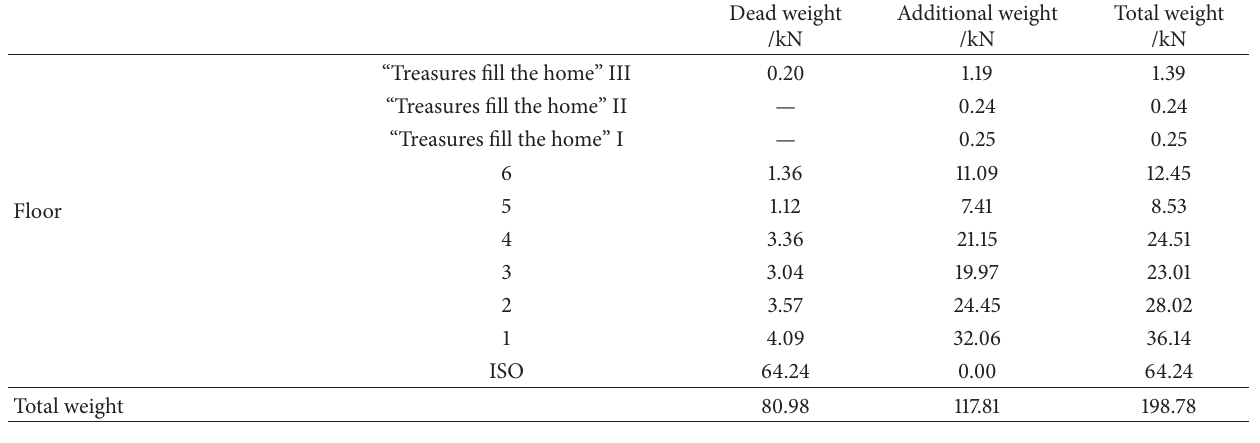
Table 6: Weight of prototype and scale model.